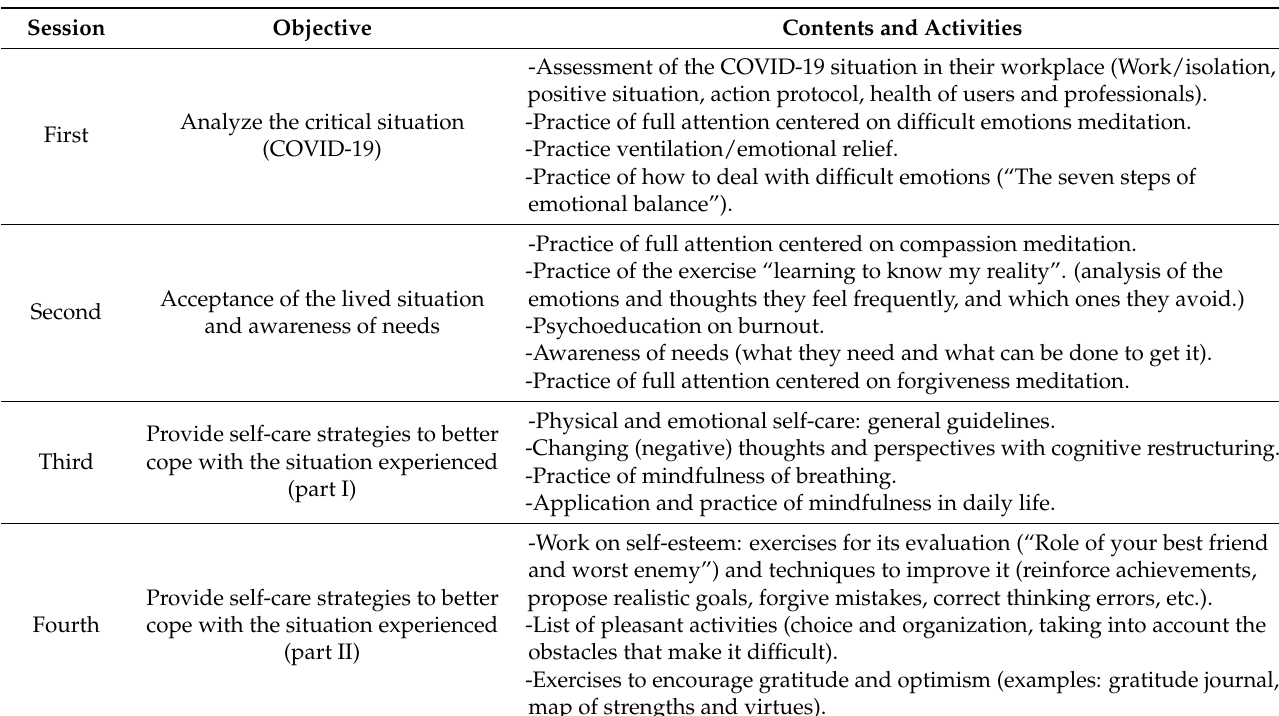
Table 2. Theoretical content and objectives in the “Professionals in emotional crisis: COVID-19”